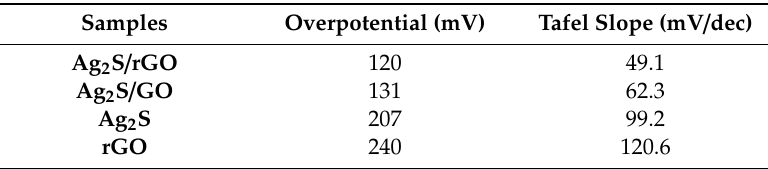
Table 1. Characteristics of Ag 2 S / rGO for the HER.